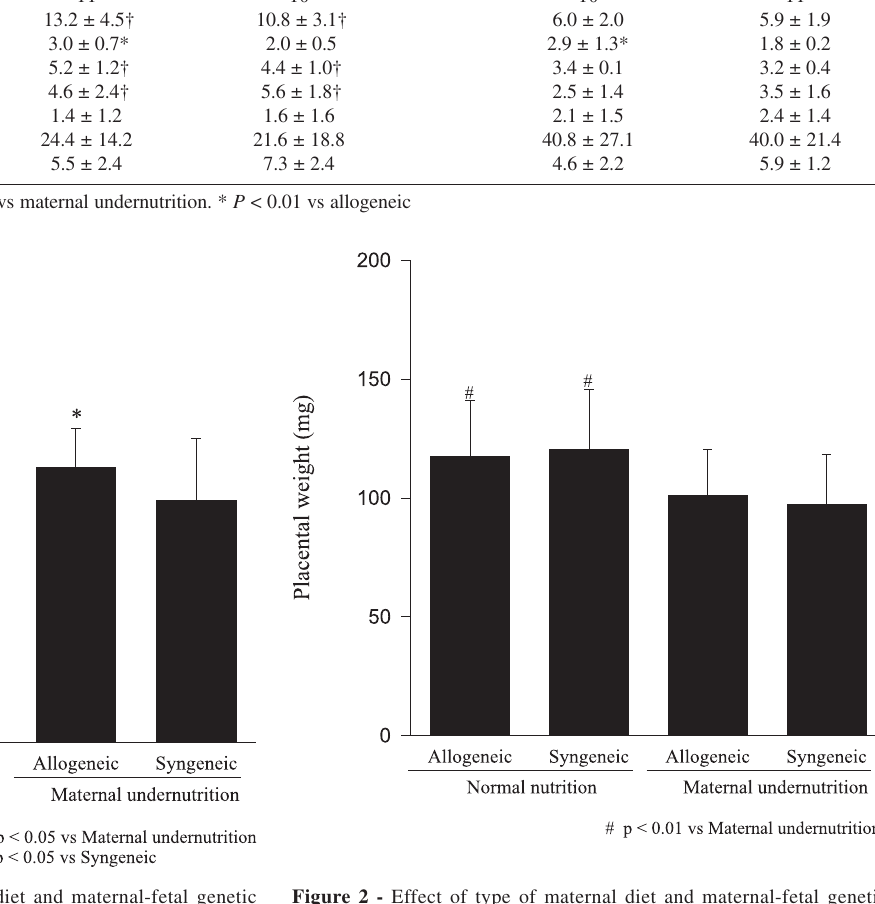
Figure 2 - Effect of type of maternal diet and maternal-fetal genetic compatibility on placental weight (mean ± SD).